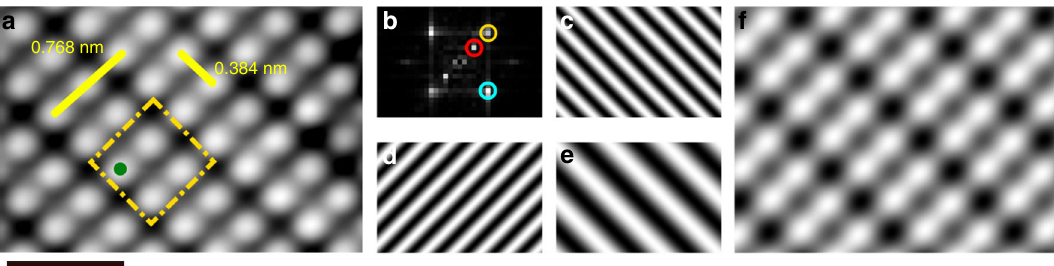
Fig. 1 Surface geometry of hydrogen-passivated Si(100)-2×1. a ( V = 1.4 V, I = 50 pA, T = 4.5 K, 2 × 3 nm 2 ) Scanning tunneling microscope (STM) image of hydrogen atoms bonded to the Si(100)-2×1 surface. The distance between identical sites along and across a dimer row are shown in yellow (solid). The surface geometry allows for the creation of single atom bits at ultra-high densities. The area of one bit (including spaces between atoms), 0.590 nm 2 , is outlined in yellow (dashed), and is de fi ned as a binary zero. The hydrogen atom denoted with a dot (green) is removed with an STM tip to create a dangling bond, changing the bit to a binary one. b 2D-Fourier transform (power spectrum) of a , where the three dominant spatial frequencies have been isolated. c – e Filtered STM images of a , for each dominant frequency (peak) shown in b , c bottom peak (blue), d top peak (yellow), e middle peak (red). f The resulting image from the sum of frequencies shown in c – e , reconstructing the essential features of the STM image shown in a , allowing for the position of each surface hydrogen atom to be determined. Scale bar,